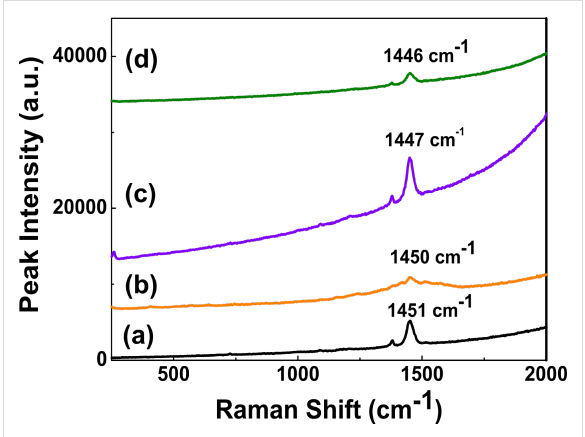
Figure 10: Raman Spectra of (a) P3HT; (b) P3HT:CISe, (c) P3HT:CIGSe, and (d) P3HT:CZTSe nanocomposites.